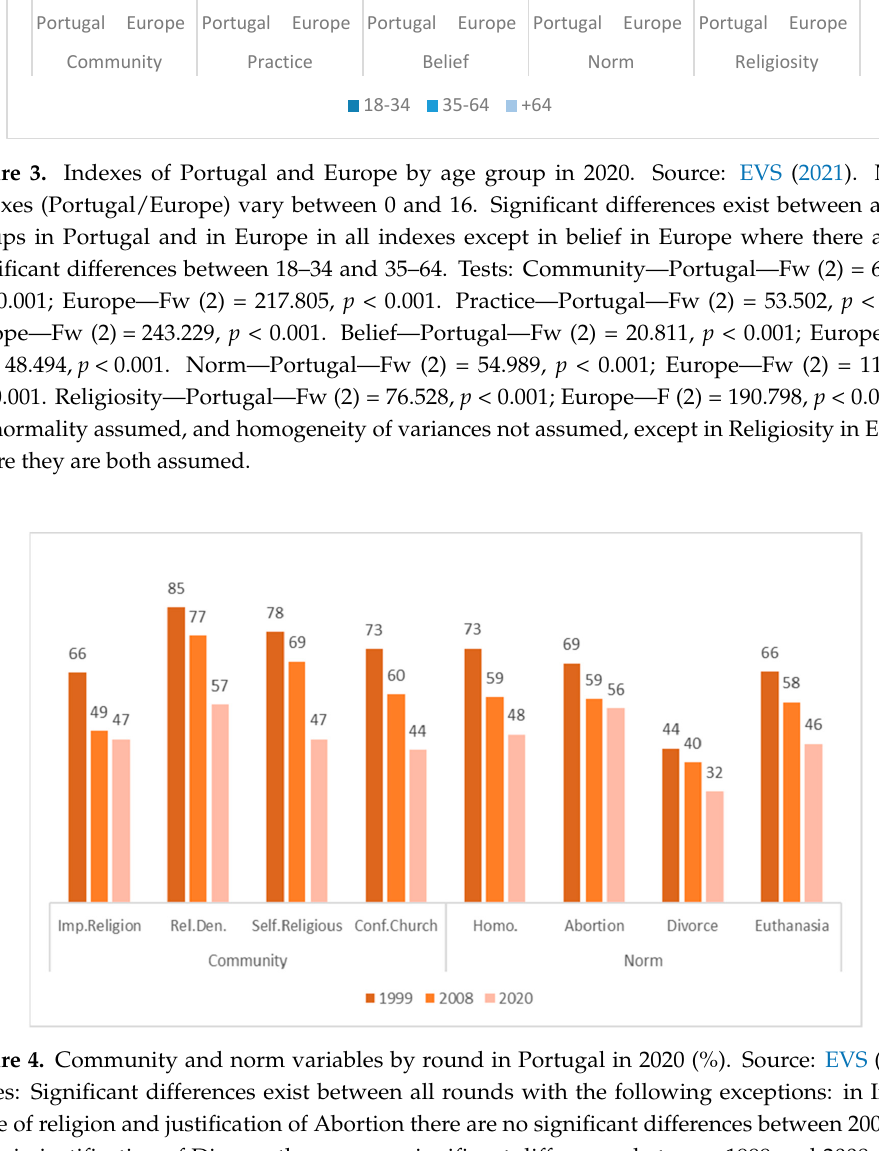
Figure 5. Practice and belief variables by round in Portugal in 2020 (%). Source: EVS (2021) . Notes: Significant differences exist between all rounds with the following exceptions: in belief in Life after death, there are significant differences only between 2008 and 2020; in belief in Hell, there are no significant differences between all age groups; in belief in Heaven, there are significant differences only between 1999 and 2020; in belief in Personal God, there are no significant differences between 2008 and 2020. Tests: Rel.Services—Fw (2) = 20.242, p < 0.001. Prayer—Fw (2) = 19.593, p < 0.001. God—Fw (2) = 33.732, p < 0.001. Life—Fw (2) = 6.634, p = 0.001. Hell—Fw (2) = 2.491, p = 0.084. Heaven—Fw (2) = 3.012, p = 0.050. Personal God—Fw (2) =7.872, p < 0.001. Imp.God—Fw (2) = 21.550, p < 0.001. In all, normality assumed, and homogeneity of variances not assumed.